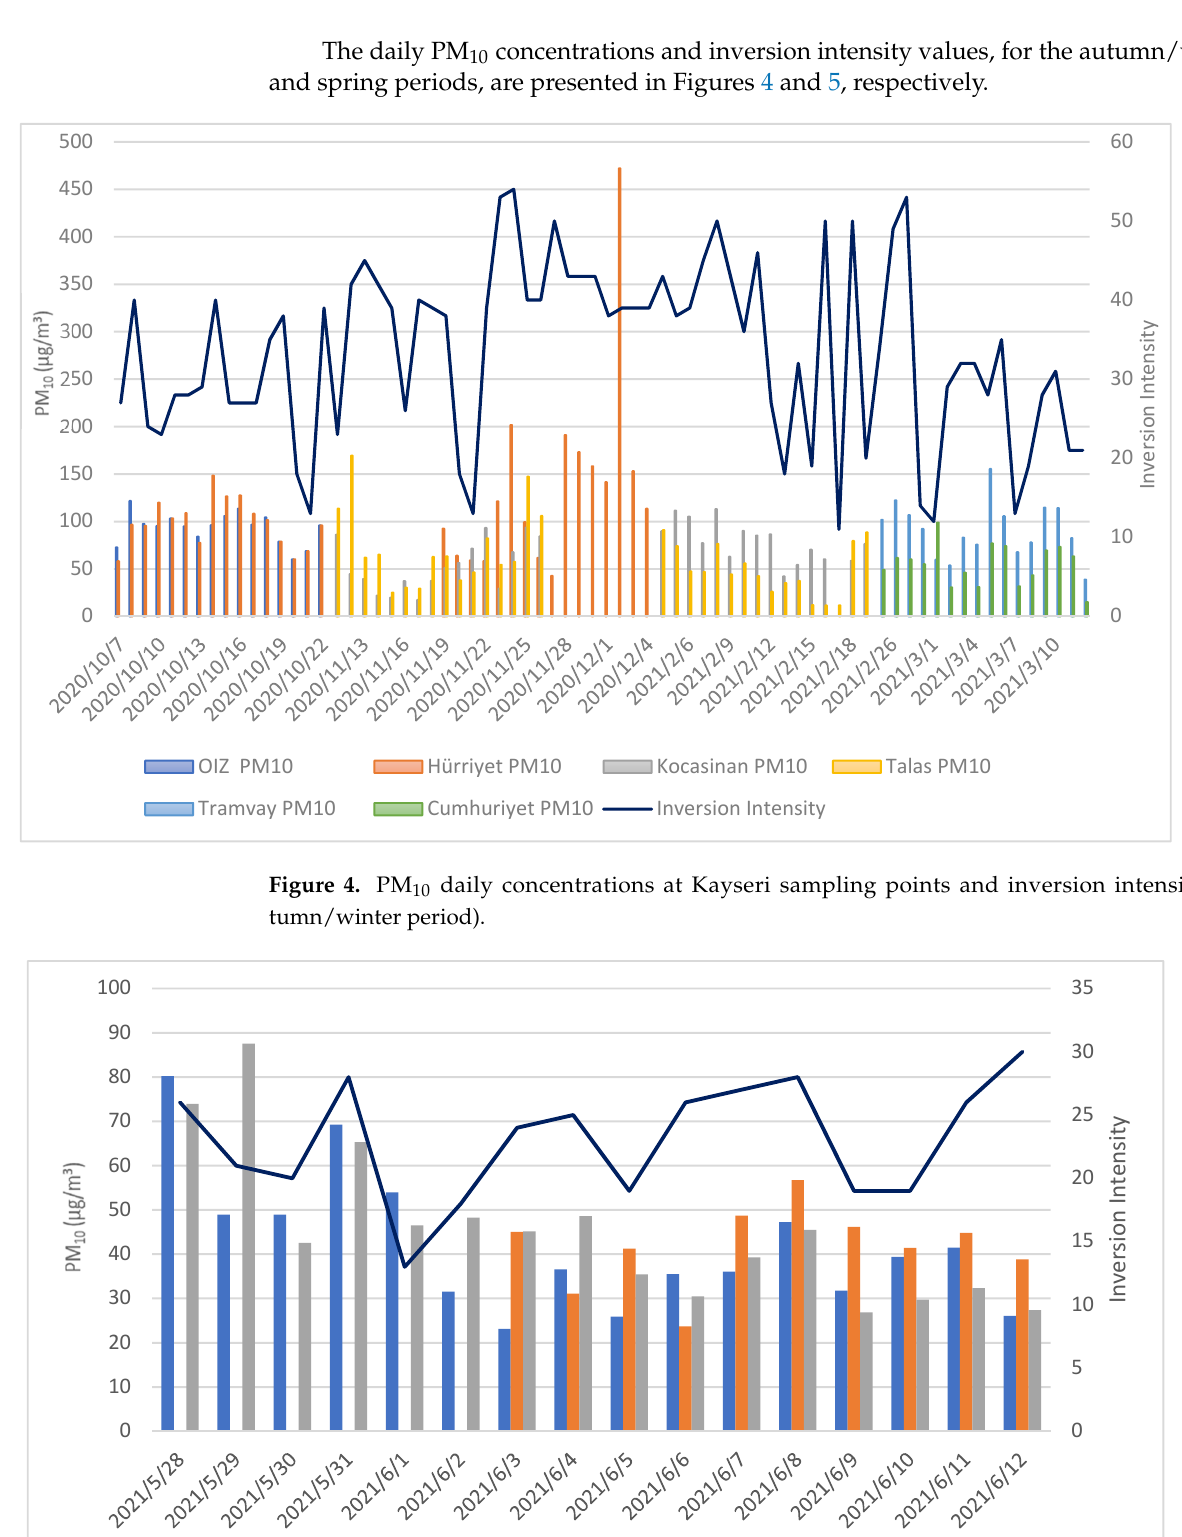
Figure 3. Comparison of daily average PM 10 concentrations with the EU Directive daily limit value, the WHO daily guideline value for PM 10 , and the number of exceedance days.